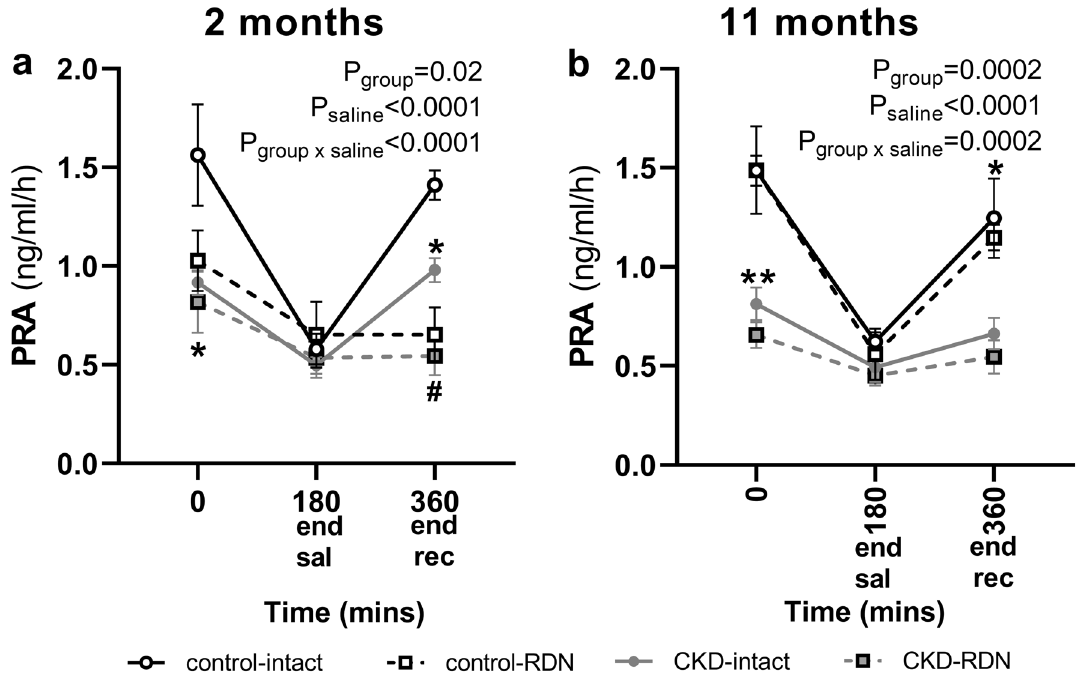
Figure 2. Plasma renin activity (PRA) in normotensive and hypertensive CKD sheep at 2 and 11 months after sham (intact) or renal denervation (RDN) procedure. Data presented at end of hour baseline (0 min), at the end of 180 min of saline infusion (end saline) and at the end of the 180 min recovery period post saline infusion (end rec). Data are mean ± SE. *P < 0.05, **P < 0.01 comparing control-intact with CKD-intact, # P < 0.05 comparing CKD-intact with CKD-RDN from post-hoc analysis following repeated measures ANOVA.